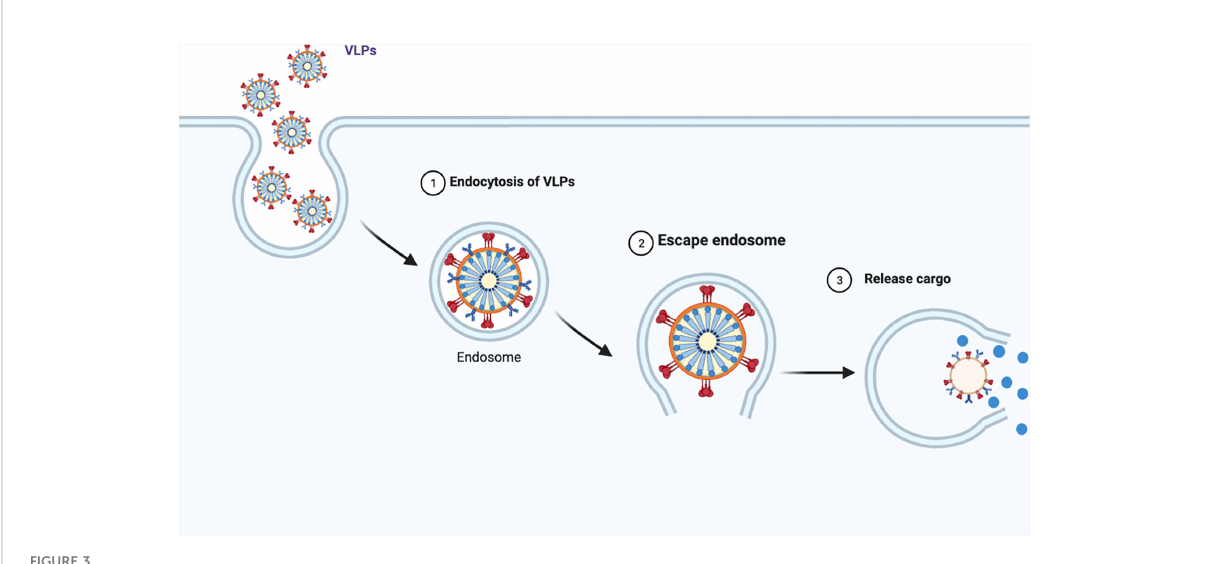
FIGURE 3 VLPs undergo endocytosis and following intracellular release of the vesicles, they migrate along the cytoskeleton to merge with early endosomes (1) (Zdanowicz and Chroboczek, 2016). Once endocytosed, the VLPs escape the endosome and then disassemble to release their cargo (2 and